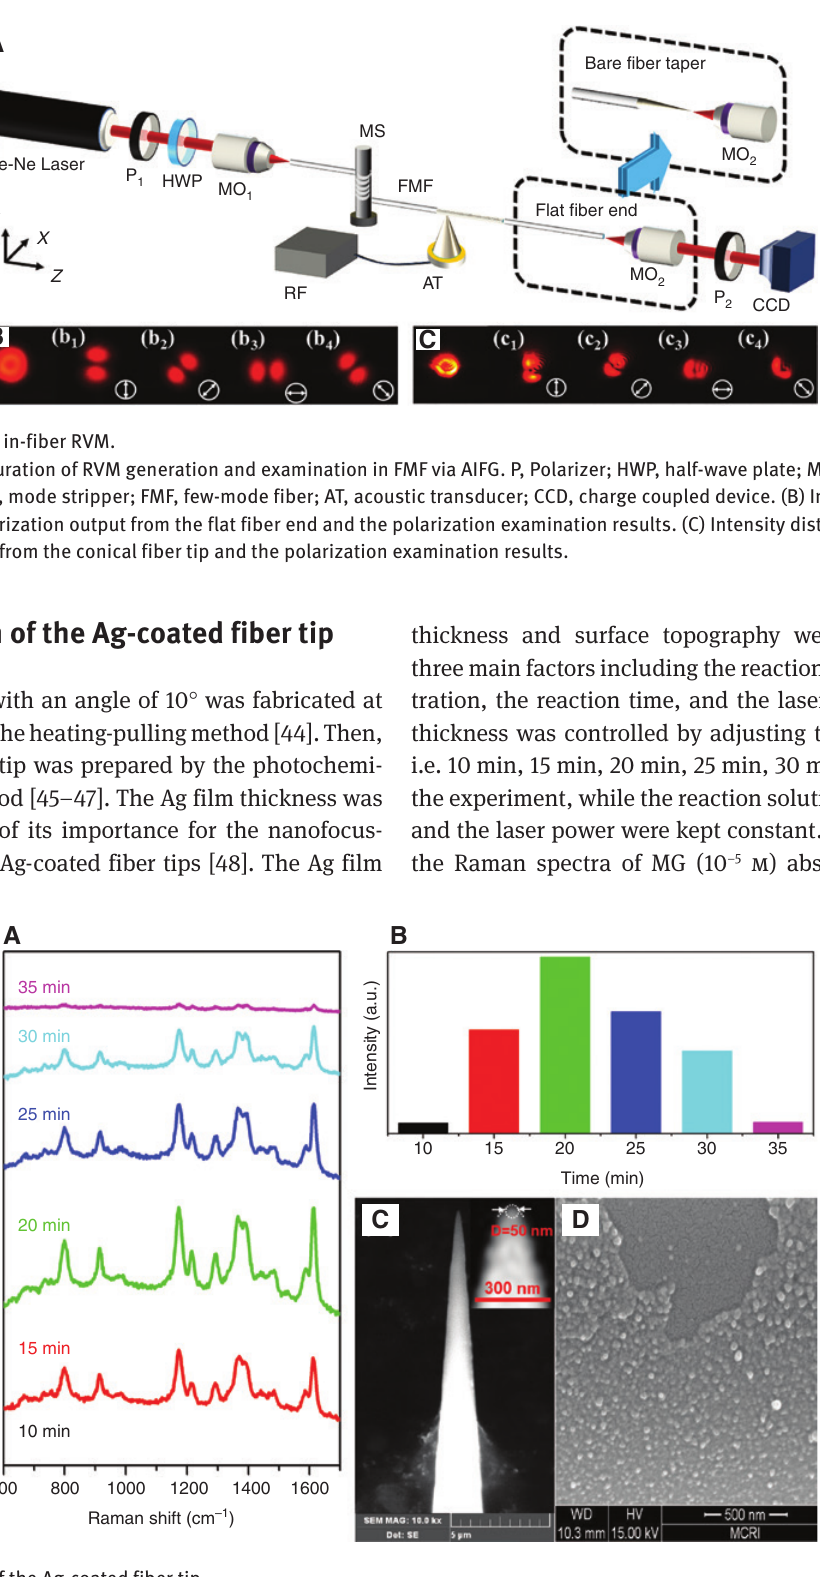
Figure 4: Preparation of the Ag-coated fiber tip. (A) Raman spectra of MG (10 −5 m) internally excited with OM TM as a function of the photochemical deposition time. (B) Histogram of the 01 intensities of the 1613.5 cm −1 characteristic peak as shown in (A). (C) SEM image of the Ag-coated fiber tip with deposition time of 20 min. (D) Local magnification of (C) with part of Ag film stripped from the Ag-coated fiber